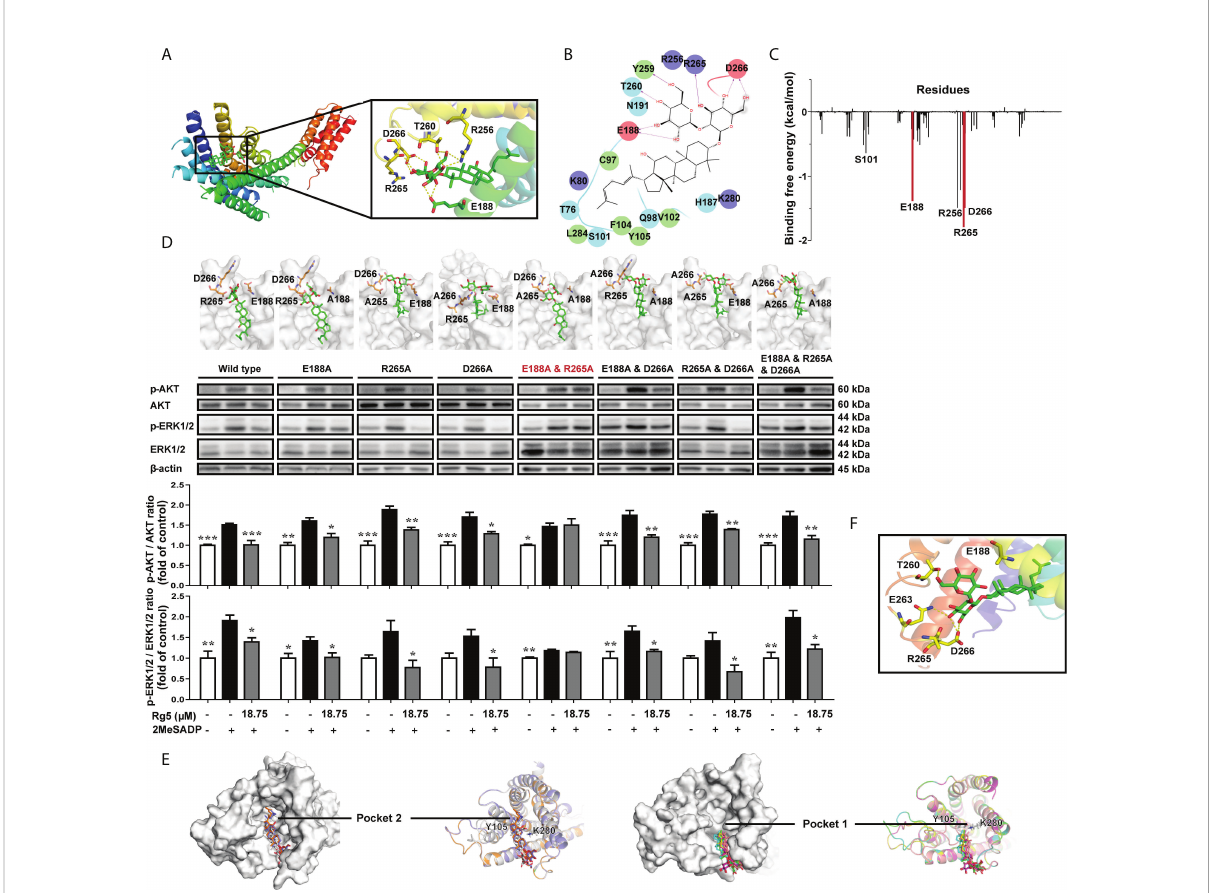
FIGURE 3 Interaction sites of Rg5 with P2RY 12 . (A) P2RY 12 and Rg5 complex structure, and binding pocket with Rg5. (B) Two-dimensional interaction map of interactions between Rg5 and P2RY 12 . (C) Energy decomposition of amino acid residues in P2RY 12 and Rg5 based on MM/PBSA free energy calculation. (D) Structures of P2RY 12 mutation variants with Rg5 bound were shown in the upper panel, and Western blot analysis in the lower panel displayed the protein expression and phosphorylation levels of AKT (n = 4) and ERK (n = 4). All the data are shown as the mean ± SEM. * P < 0.05, ** P < 0.01, *** P < 0.001 vs. 2MesADP group. (E) Hypothetical binding modes of Rg5 to P2RY 12 mutation variants obtained by molecular docking. The binding conformation of Rg5 in each P2RY 12 mutant were colored as follows: white, original; slate, E188A; orange, E188A and R265A; magenta, R165A;